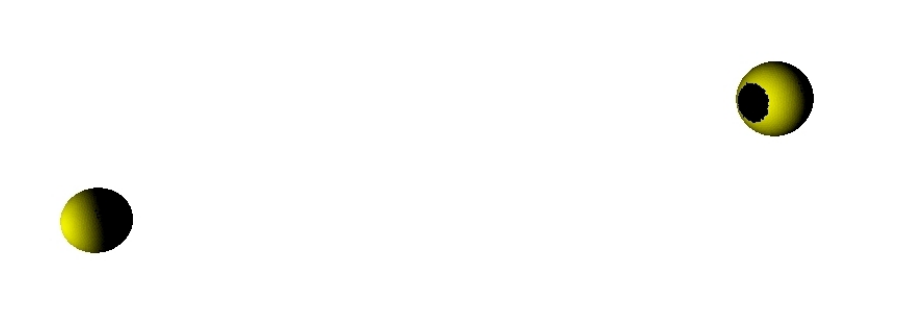
Figure 12. Shadowing of Pluto (right) by its largest moon Charon (left) during lunar eclipse (idealized). Both bodies are located on the x -axis, coordinates: Pluto (0,0,0), Charon (19,596,0,0), sun vector